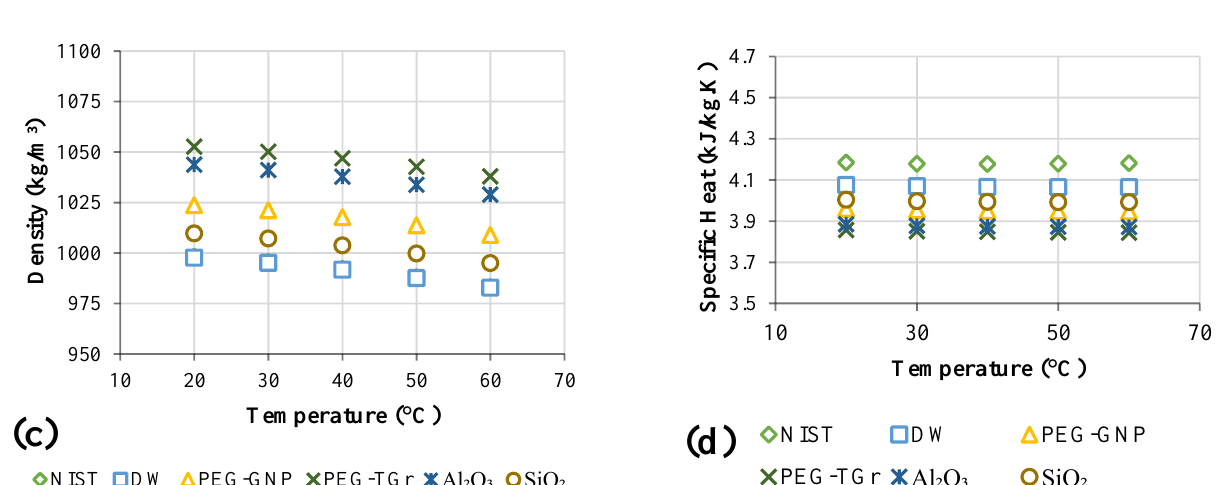
Figure 5. The thermophysical properties of base fluid and nanofluids; ( a ) Thermal conductivity, ( b ) Dynamic viscosity, ( c ) Density, ( d ) Specific heat capacity.